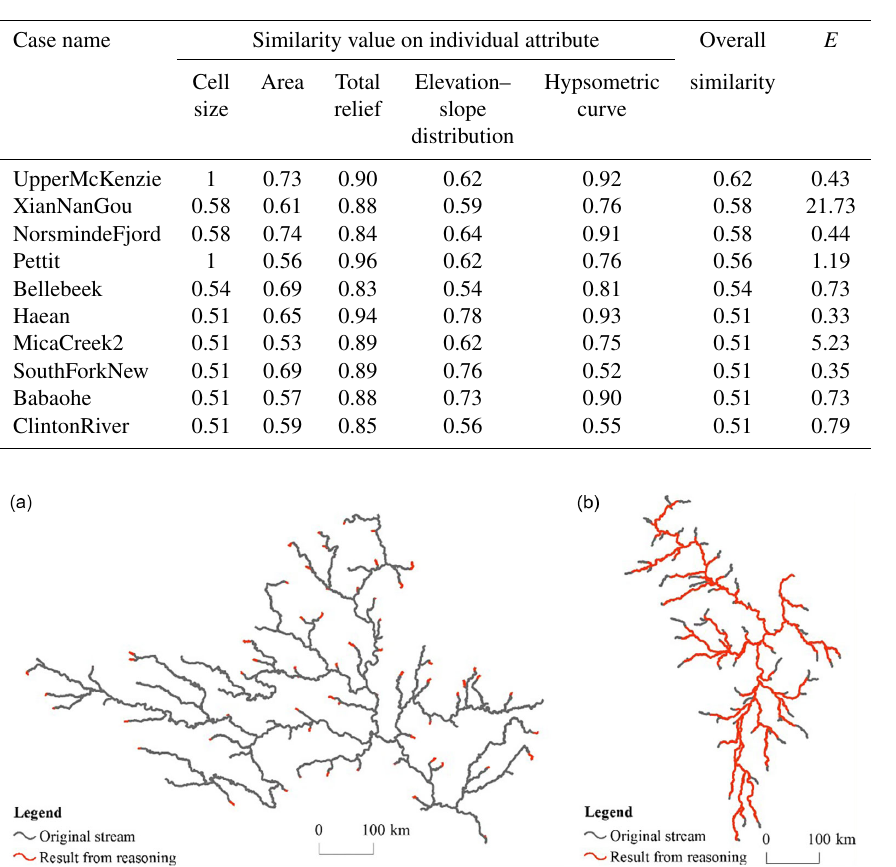
Table 5. Top 10 similarity values between the YbbsRiver evaluation case and existing cases as reasoned by the proposed method.